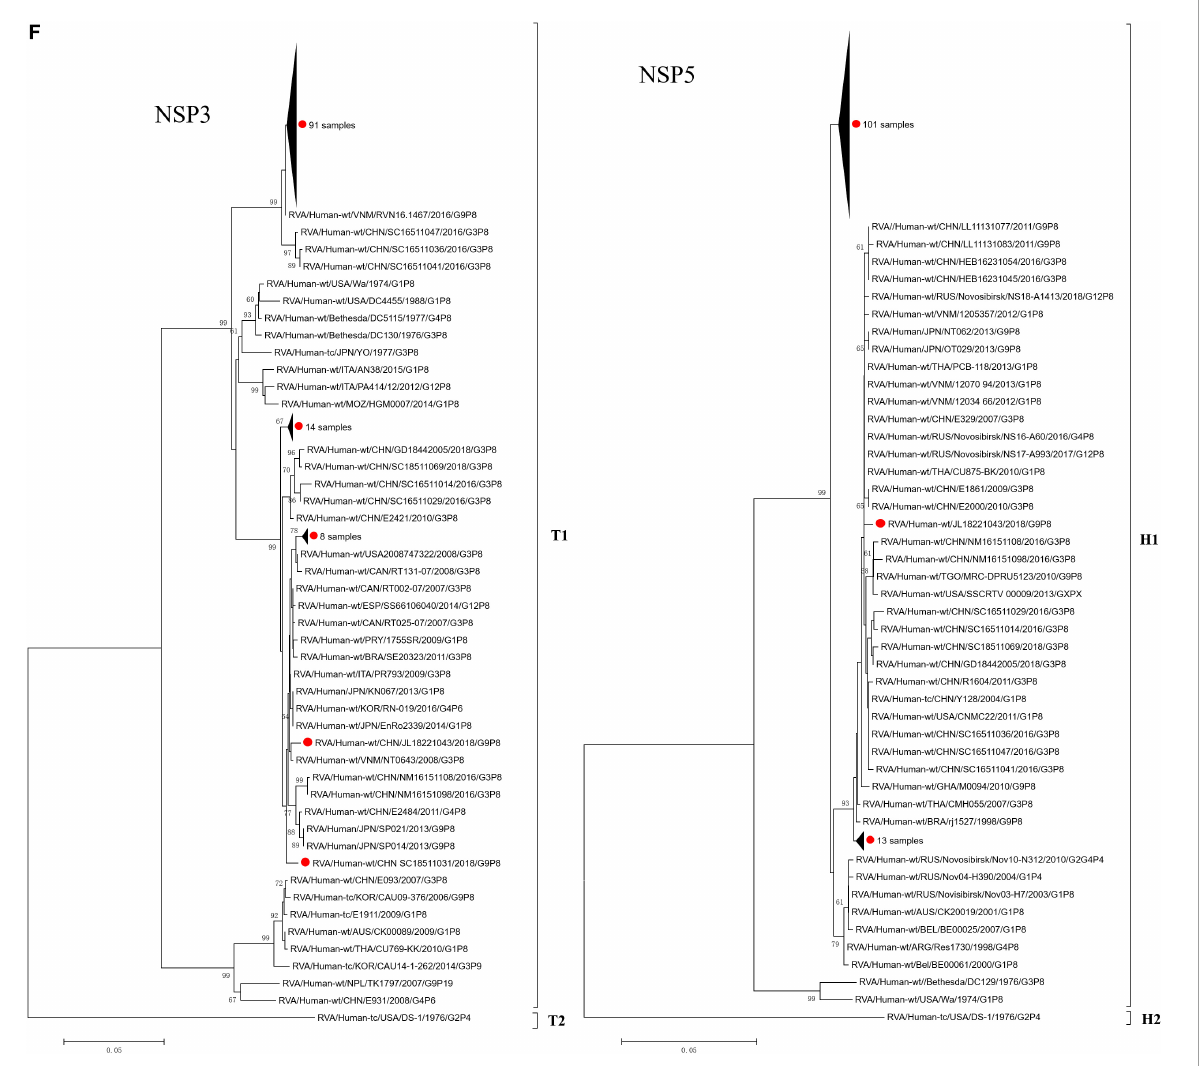
FIGURE2 Phylogenetic dendrograms based on the nucleotide sequences of the 115 gene segments of rotaviruses for VP7 (A) ; VP4 (B) ; NSP4 (C) ; VP1-VP3 (D) ; VP6, NSP1, and NSP2 (E) ; NSP3 and NSP5 (F) in China from 2016 to 2018 ( • ). In VP4 vaccine strains are reported in bold. Trees were constructed by the maximum-likelihood method with 1,000 bootstrap